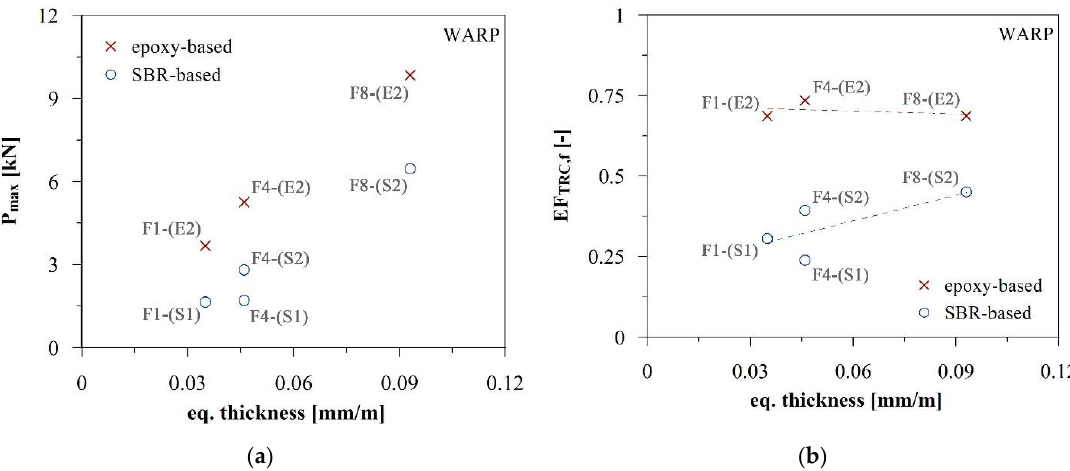
Figure 13. Average maximum load ( a ) and fabric efficiency ( b ) vs. equivalent thickness of the investigated textiles in the case of TRC composites reinforced with the fabrics in the warp direction.